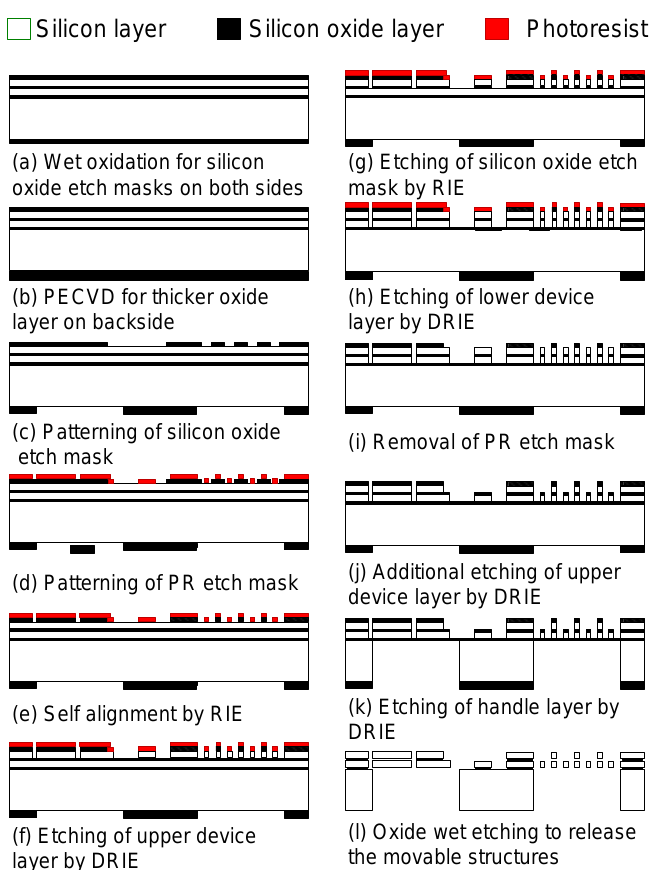
Figure 7. Fabrication process for the torsional resonator integrated with frequency tuning unit. The device is fabricated on a double silicon ‐ on ‐ insulator (DSOI) wafer. Reproduced with permission from [26].